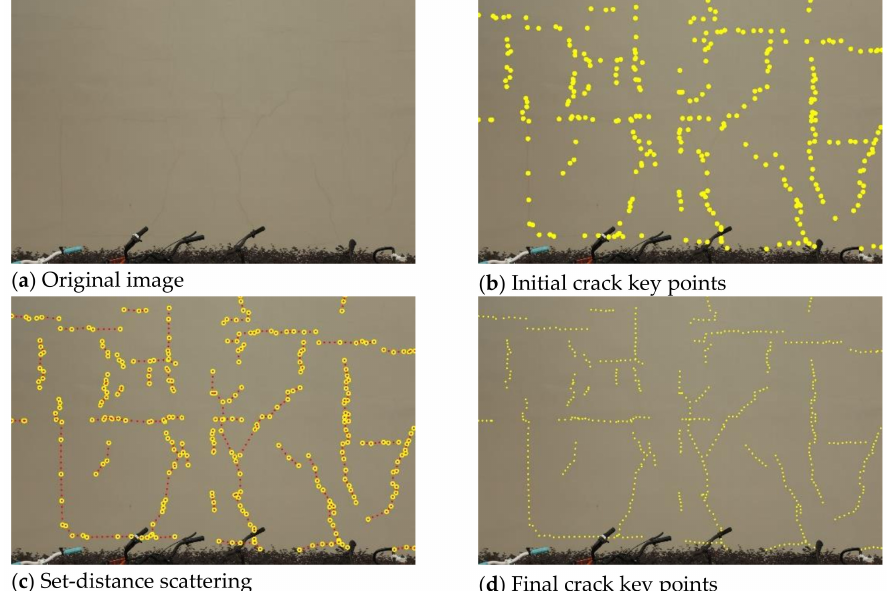
Figure 3. The process and result of set-distance